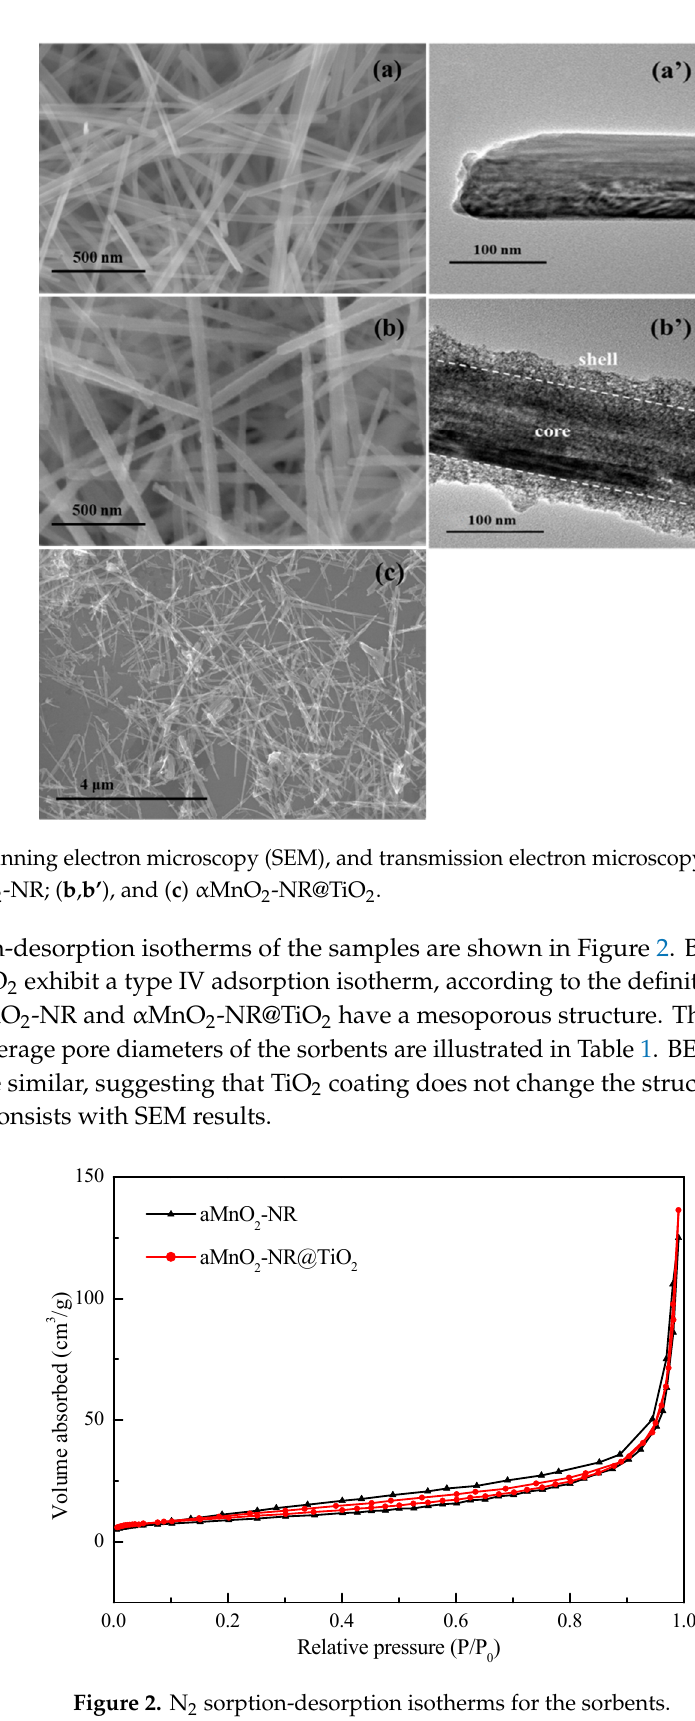
Figure 2. N 2 sorption-desorption isotherms for the sorbents.